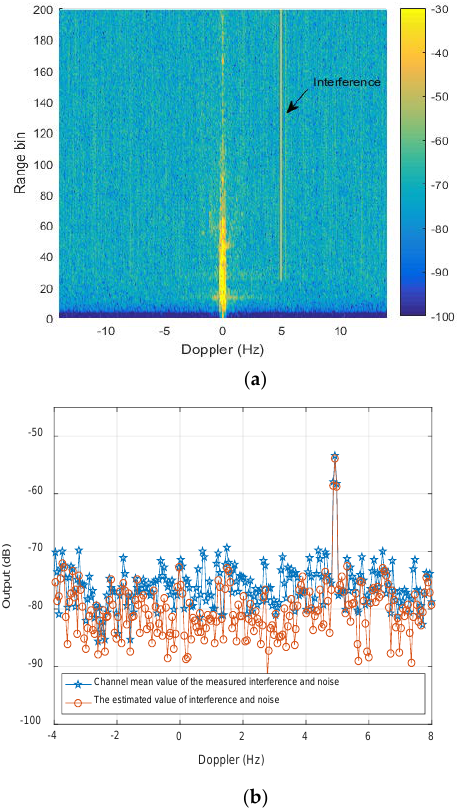
Figure 5. The estimated result with the measured HFSWR data: ( a ) Range-Doppler spectrum; ( b ) Doppler profile at the 100th range bin.